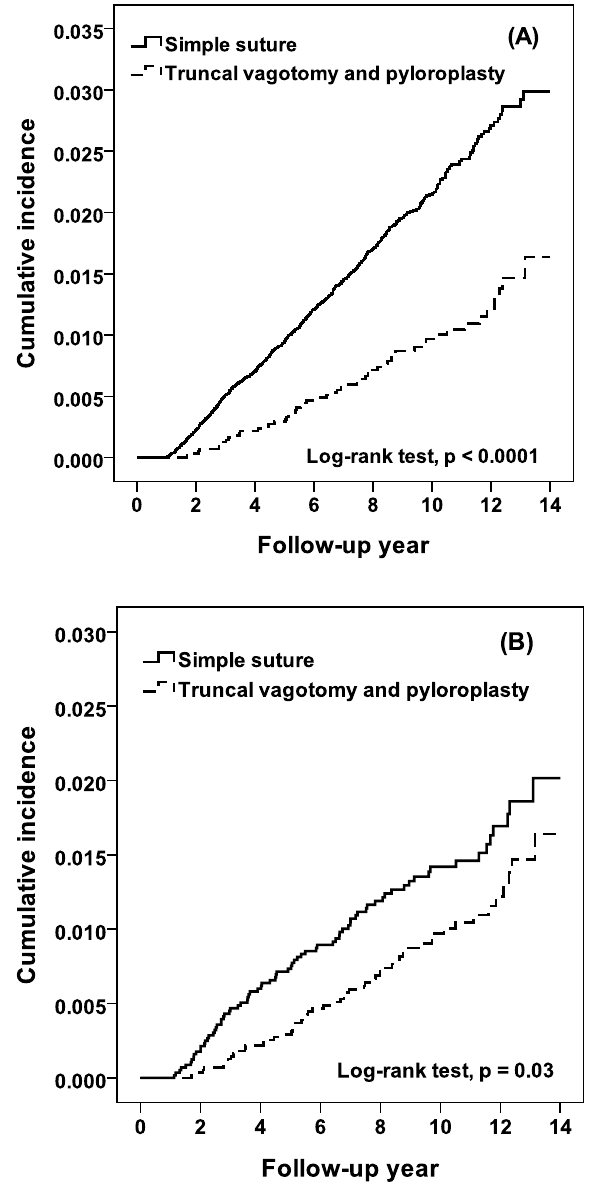
Figure 2. Cumulative incidence for liver cancer in non-HP infected PPU patients with simple suture and truncal vagotomy/pyloroplasty using Kaplan–Meier analysis. ( A ) All subjects, and ( B ) propensity score matching